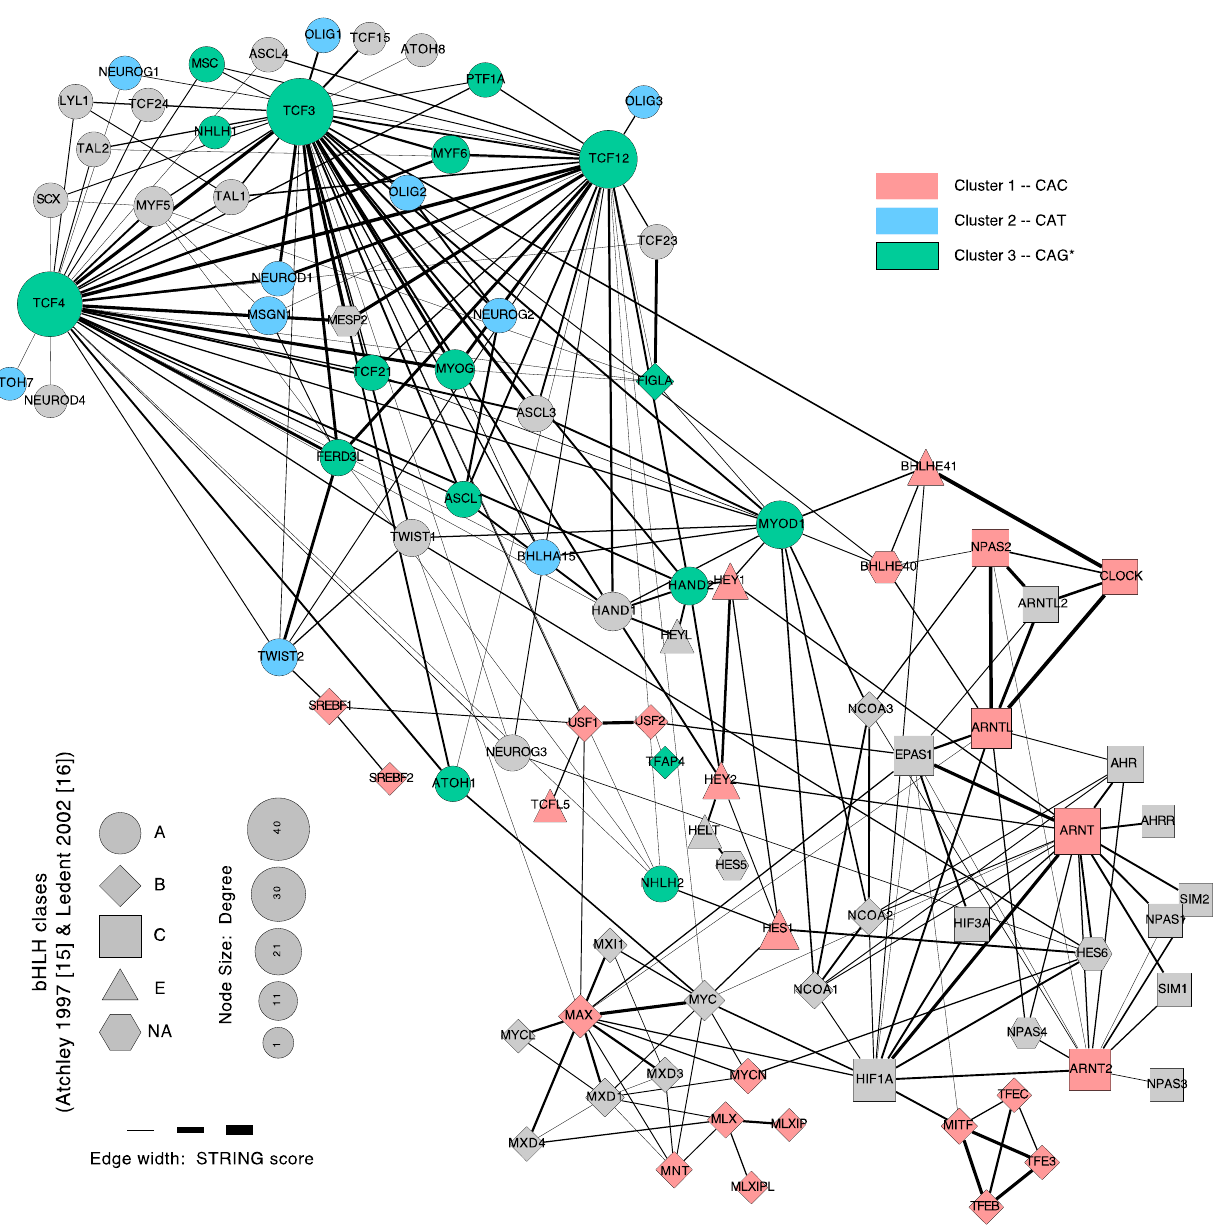
Figure 4. Network representation of protein-protein interactions among bHLH TF catalogued in the STRING database. Only experimental/biochemical score was taken into account, from experiments of human and mouse proteins. When experimental data was available for both species, the highest score was considered. STRING score is reflected in the width of edges in the network, while the size of each node represents its degree centrality. The shape of each node indicates the bHLH classification by Atchley and Fitch [15] and Ledent et al. [16]. Nodes are colored by the motif similarity cluster derived from Figure 2.